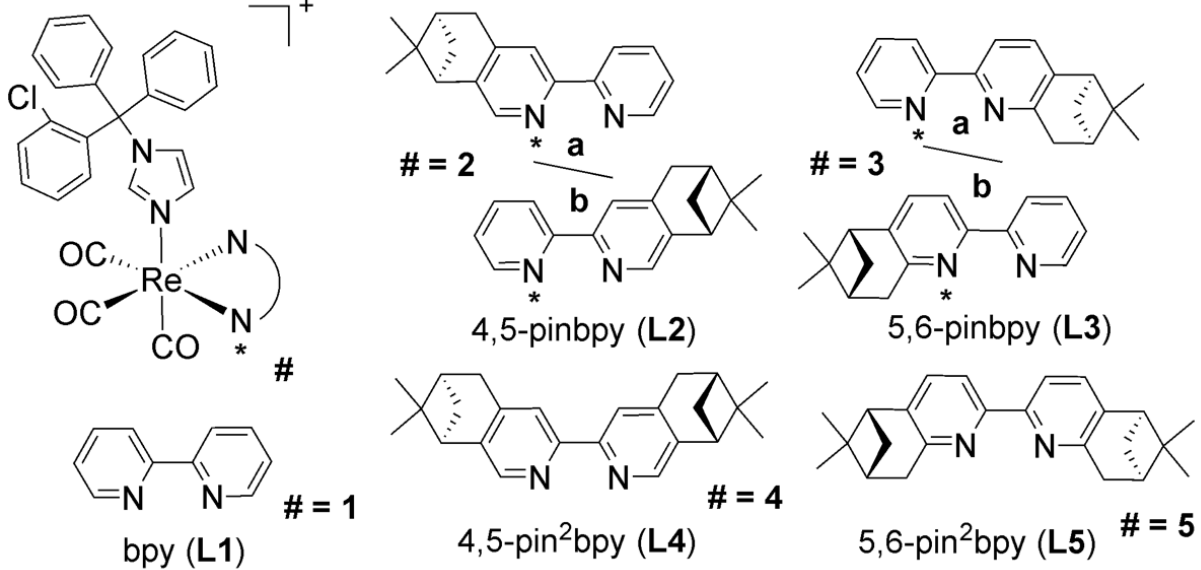
Figure 3. Molecular structure of Re-ctz complexes used for molecular docking with receptor SaMurG. Note that the # refers to the complexes. The corresponding 4,5-pinene and 5,6-pinene bipyridine are referred as L# in the text. The * refers to the specific nitrogen atom coordinated to the Re center as depicted for the complex on the top left.